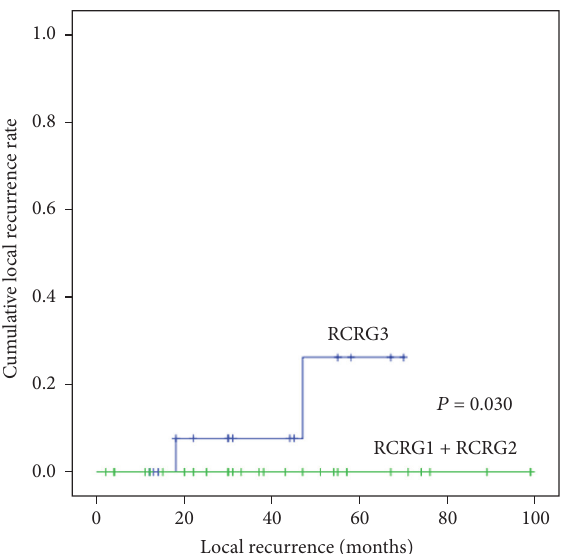
Figure 2: Cumulative local recurrence rate in nCRT group between RCRG1 + RCRG2 and RCRG3. RCRG: rectal cancer regression grade; nCRT: neoadjuvant